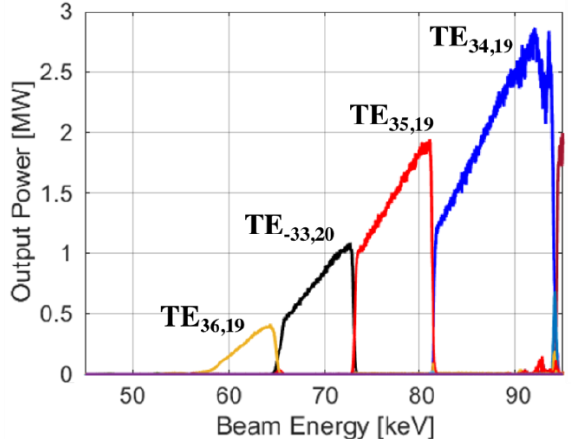
Fig. 4. Realistic start-up scenario with the existing coaxial cavity at 6. 86 T and I beam = 75 A without non-linear uptaper using the magnetic field profile proposal from the new SC magnet and the gun parameters from the new coaxial